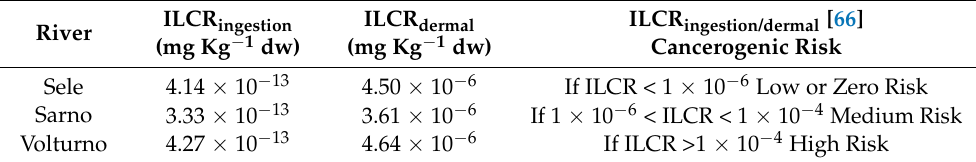
Table 9. Incremental lifetime cancer risk values (ILCR ingestion and ILCR dermal ) due to exposure by ingestion and dermal contact to the highest PAHs levels found in the sediment samples of the Sele, Volturno, and Sarno